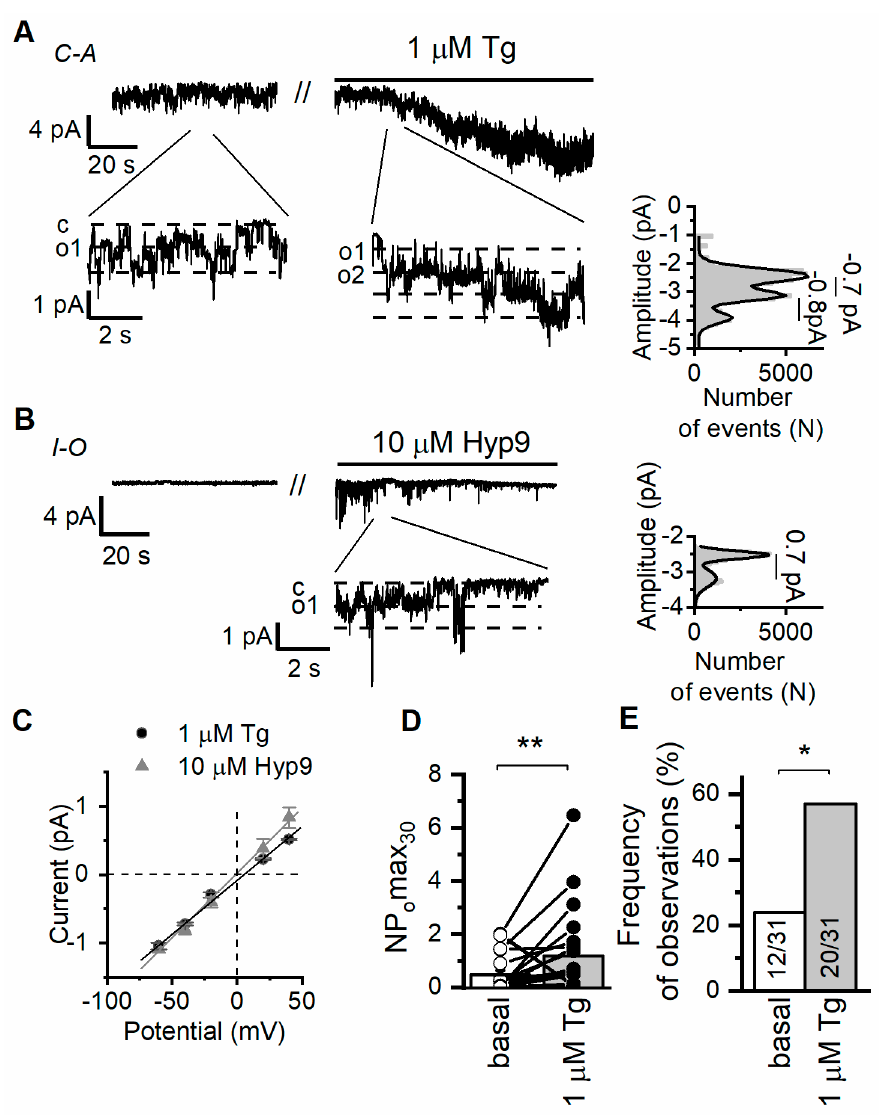
Figure 1. Ca 2+ store depletion activates TRPC6 channels in human culture podocytes Ab8/13. ( A ) Representative traces of currents recorded in cell-attached configuration in culture podocytes Ab8/13 at holding potential of − 40 mV. Shown are basal currents and currents after bath application of 1 µM thapsigargin (Tg). Fragments of the recordings and corresponding amplitude histogram after Tg application are shown at the bottom on an expanded time scale. ( B ) Representative traces of currents recorded in inside-out configurations in Ab8/13 podocytes at holding potential of − 40 mV. Shown are basal currents and currents after bath application of 10 µM hyperforin 9 (Hyp9). ( C ) The current–voltage relationship of observed TRPC6 channels in response to Tg and Hyp9. ( D ) The open channel probability collected during 30 s of maximal activity (NPomax30) before and after bath application of 1 µM Tg. Data presented as mean bar plots and paired data points were statistically analyzed using paired sample Wilcoxon signed-rank test. ( E ) The frequency of TRPC6 channel observation as portion of experiments. In bar plot are shown the number of experiments with TRPC6 activity over total number of performed experiments. Data were statistically analyzed by Barnard’s exact test. * and ** indicate p values of <0.05 and <0.01, respectively. To reveal the contribution of TRPC6 channels to SOCE, we performed Ca 2+ imaging experiments with fura-2 as Ca 2+ indicator (Figure 2). In addition, we checked the effect of different inhibitors on the SOCE in podocytes.